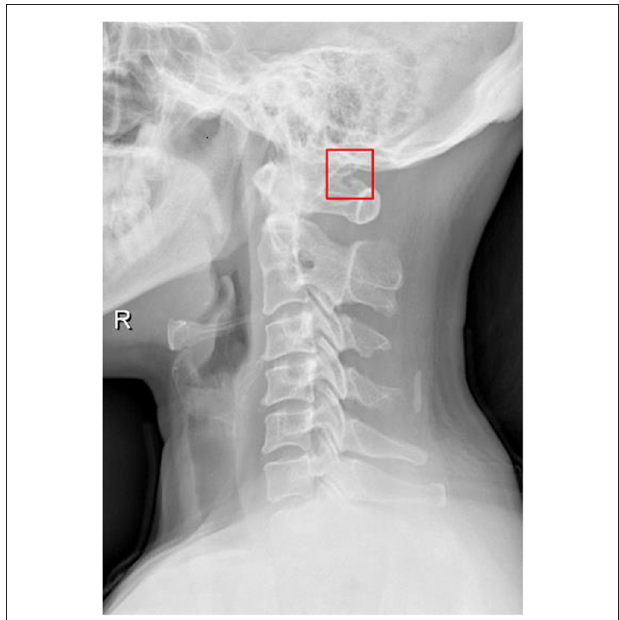
FIGURE 2 | A 44-year-old female with migraine and normal neurologic examination. Lateral radiograph showed the right-sided partial ponticulus posticus, an anomalous bony bridge formed from the superior articulating surface of the atlas but not fused to the posterior arch of the